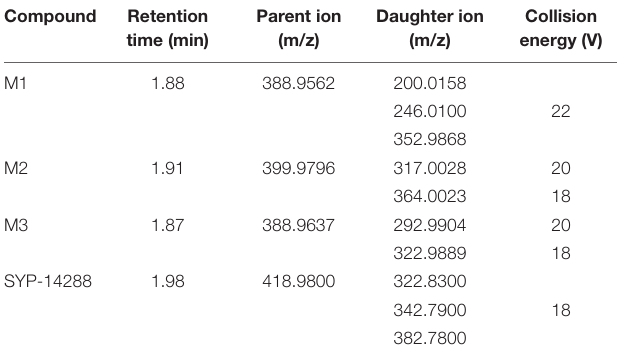
TABLE 1 | Parameters used for high-performance liquid chromatography equipment in detecting SYP-14288 and associated metabolites.